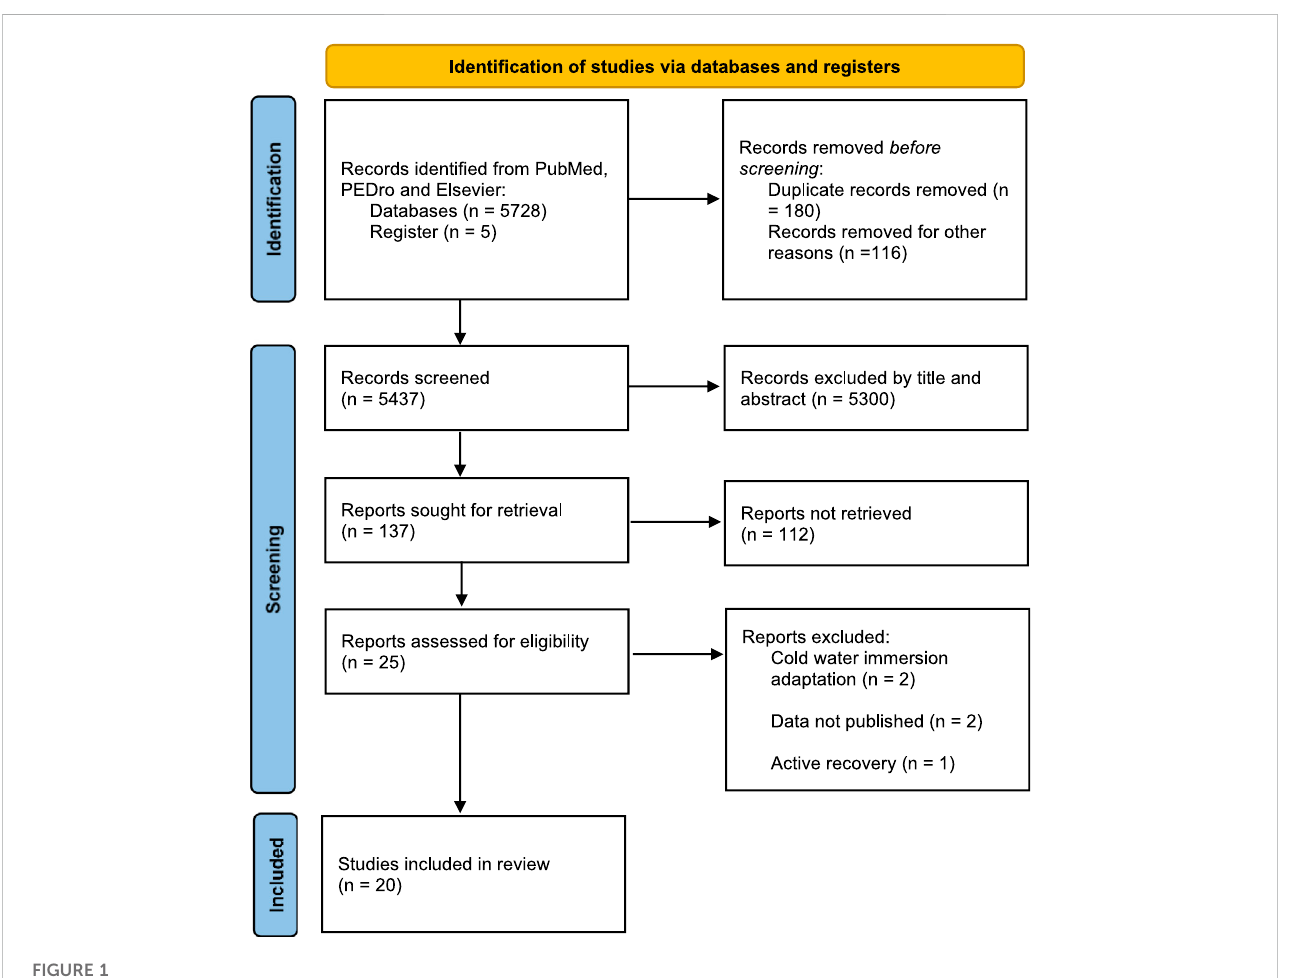
FIGURE 1 Flow-chart describing the systematic review